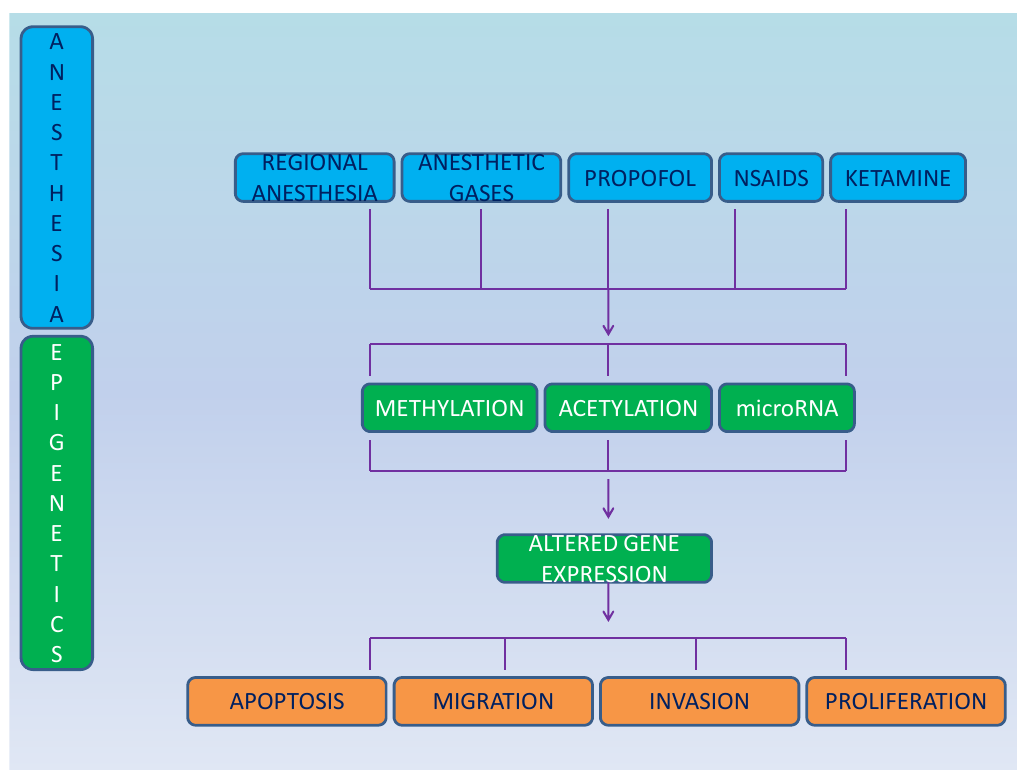
Figure 1. Schematic representation of the effect of anesthesia on epigenetics and cancer cells.